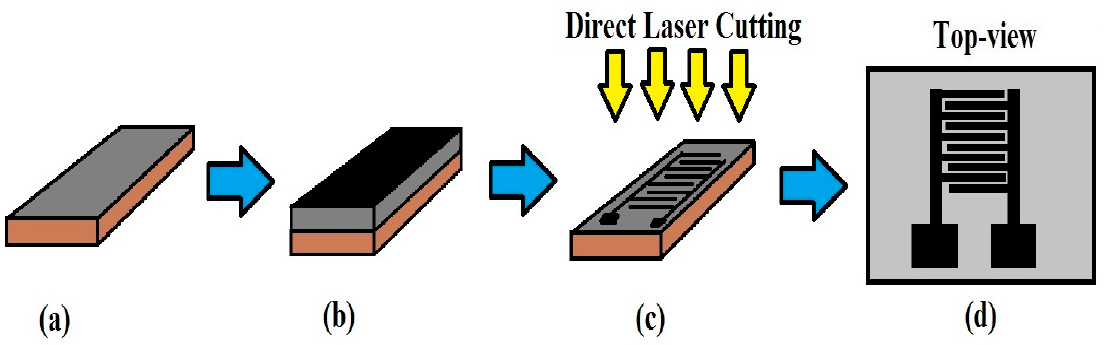
Figure 1. Fabrication steps of the CNT-PDMS-based sensor. ( a ) Casting and curing of polydimethylsiloxane (PDMS) on the poly (methyl methacrylate) (PMMA) template, ( b ) casting and curing a layer of the nanocomposite on the cured PDMS, ( c ) laser-ablation of the nanocomposite layer to form the electrodes of the sensor patch ( d ). Reproduced from Nag, A., Mukhopadhyay, S. C. and Kosel, J., 2016. Flexible carbon nanotube nanocomposite sensor for multiple physiological parameter monitoring. Sensors and Actuators A: Physical, 251, pp.148–155 [1].